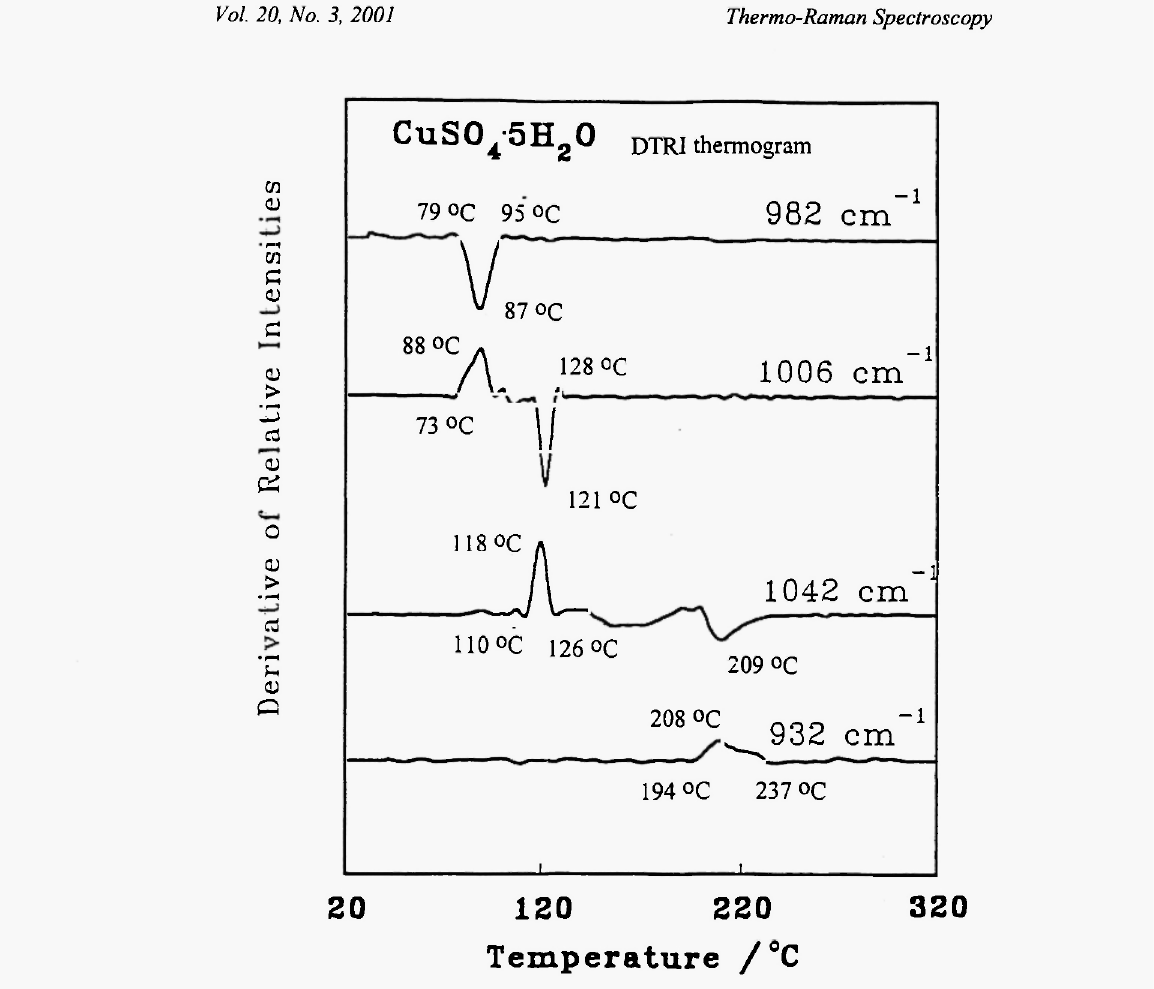
Fig. 11: The differential thermo-Raman intensity (DTRI) thermogram of the Raman bands at 982 cm" 1 (CuS0 4 -5H 2 0), at 1006 cm" 1 (CUS0 4 -3H 2 0), at 1042 cm" 1 (CuS0 4 H 2 0) and at 932 cm" 1 (CuS0 4 ) in the dynamic thermal process (Ref. 15).